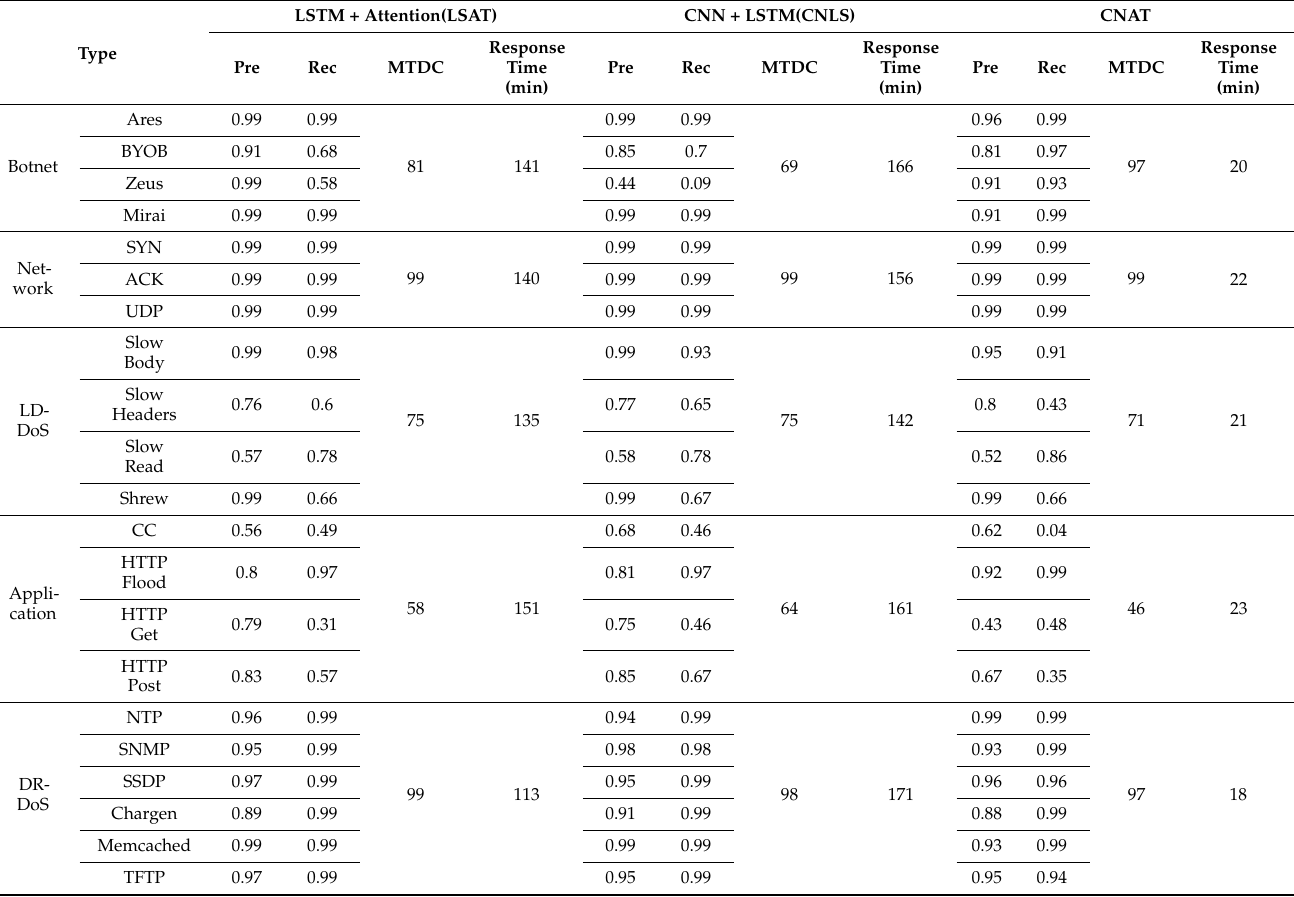
Table 6. Contrast detection